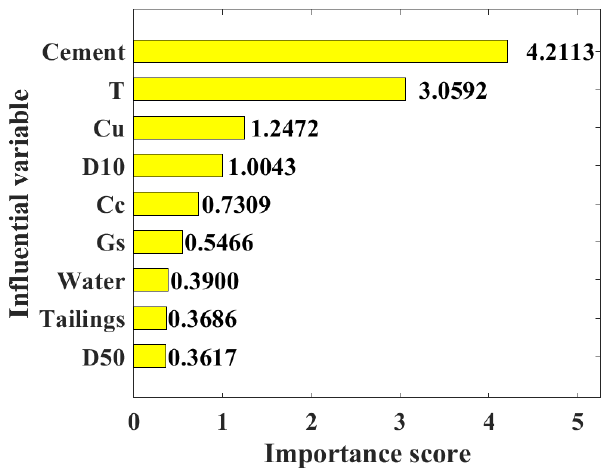
Figure 13. Importance score of the input variable.